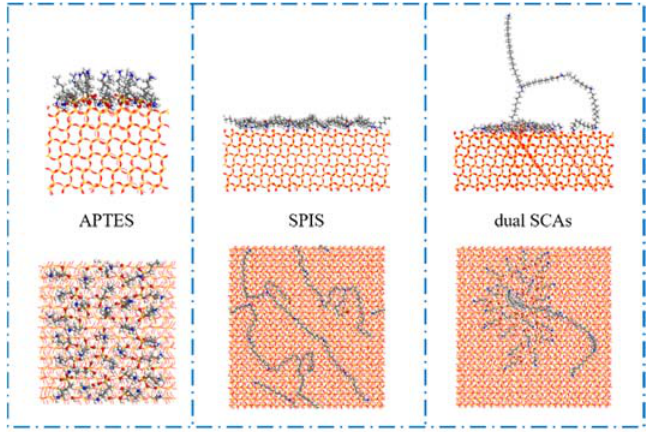
Figure 9. Stable adsorption configuration of the different SCAs on quartz surface.